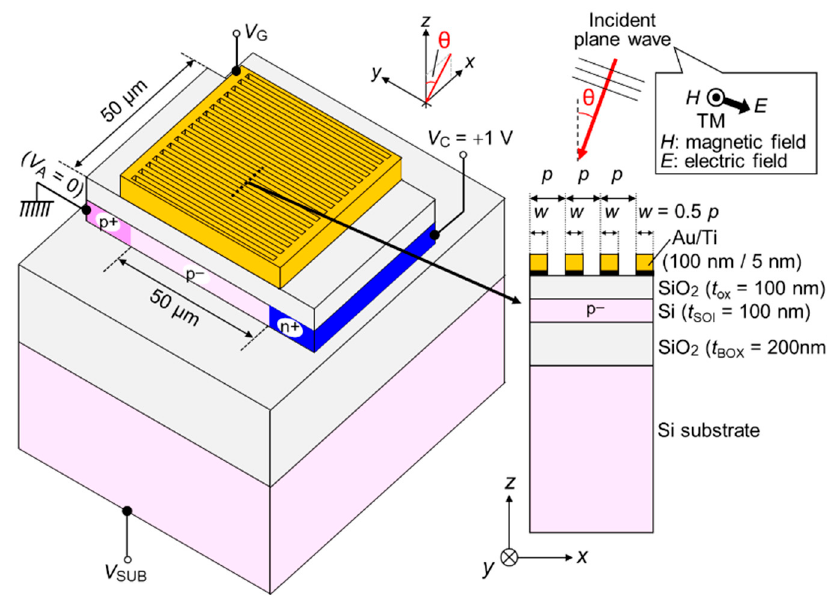
Figure 1. Bird’s-eye view and cross-sectional view of a single silicon-on-insulator photodiode (SOI PD) with surface plasmon (SP) antenna and definitions of incident polarization and incident angle θ . The light-sensitive area equivalent to p − active area is 50 × 50 μ m 2 . Gold (Au) SP antenna composed of line-and-space (L/S) structure and surrounding frame can work not only as a diffraction grating, but also as a gate electrode for higher quantum efficiency (QE) by controlling the extent and position of depletion region in SOI.